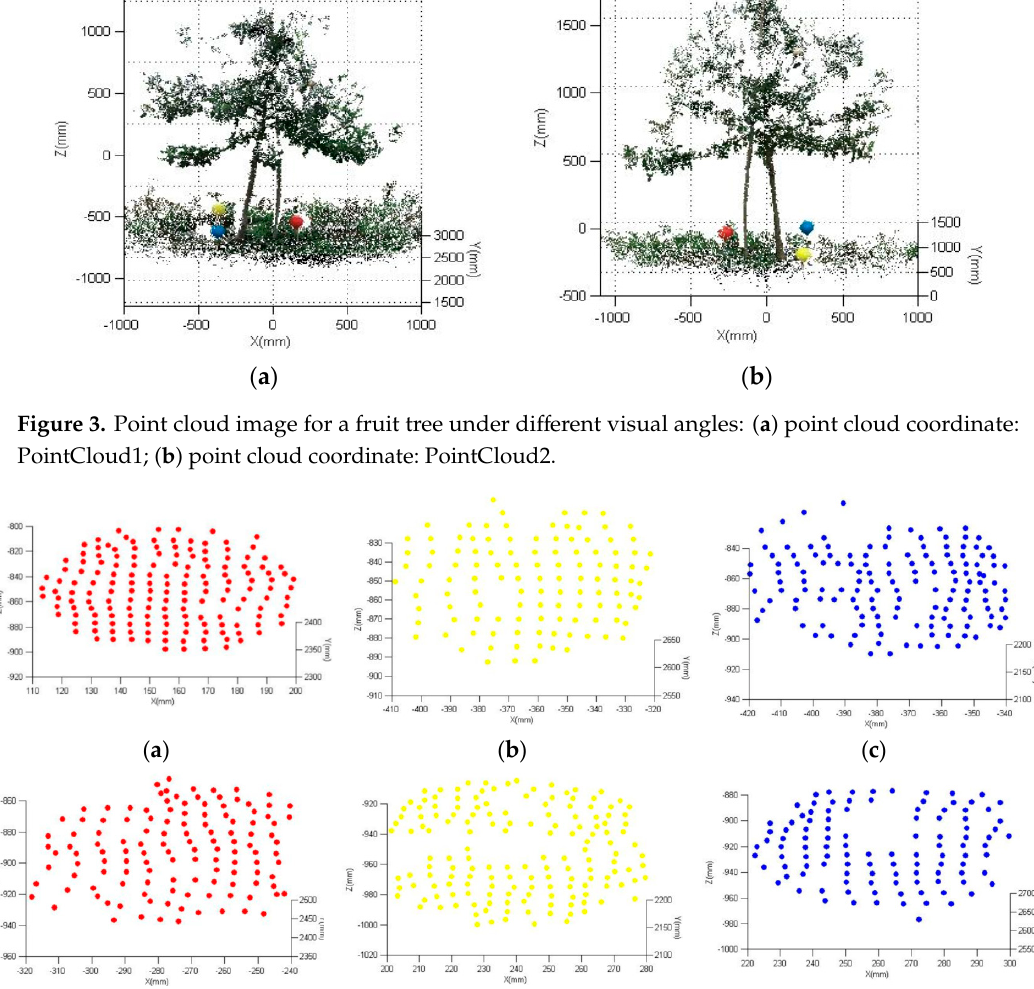
Figure 4. Identification diagram with calibration balls: ( a ) red ball point cloud from the first visual angle; ( b ) yellow ball point cloud from the first visual angle; ( c ) blue ball point cloud from the first visual angle; ( d ) red ball point cloud from the second visual angle; ( e ) yellow ball point cloud from the second visual angle; ( f ) blue ball point cloud from the second visual angle.